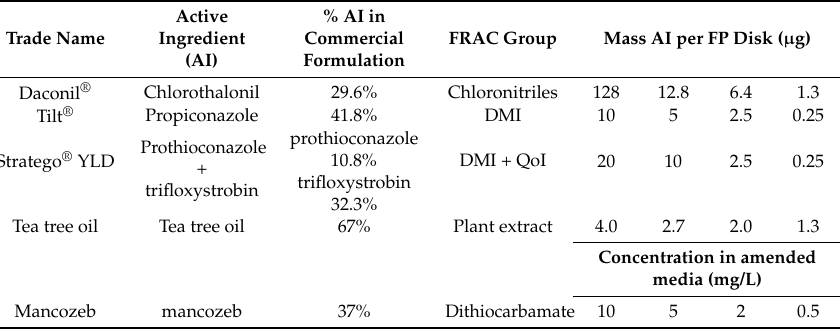
Table 8. Fungicides and dilutions used in fungicide interaction